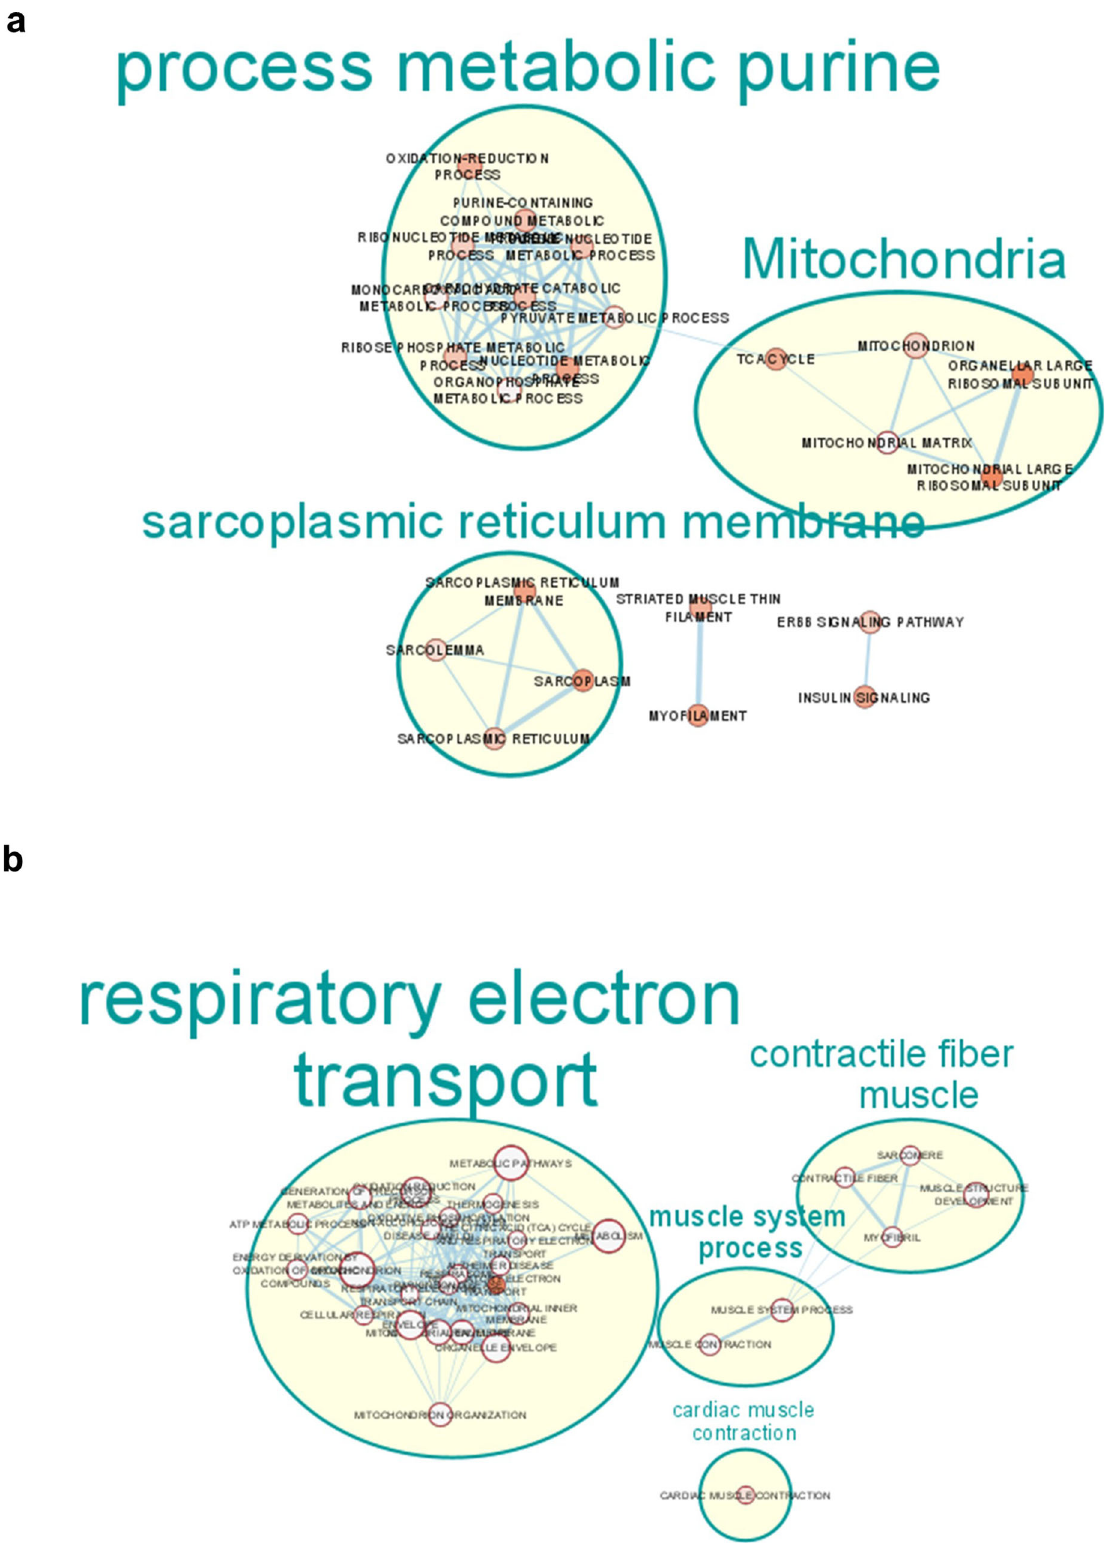
decided to explore muscle function according to vitamin D status. Vitamin D-de fi cient old mice showed signi fi cantly lower hindlimb muscle mass compared with their control counter- parts (Mouse experiment 1) (Fig. 6a). The vitamin D-de fi cient group also showed lower forelimb grip strength ( − 21% vs. control mice, p < 0.05) (Fig. 6b). These data suggest that